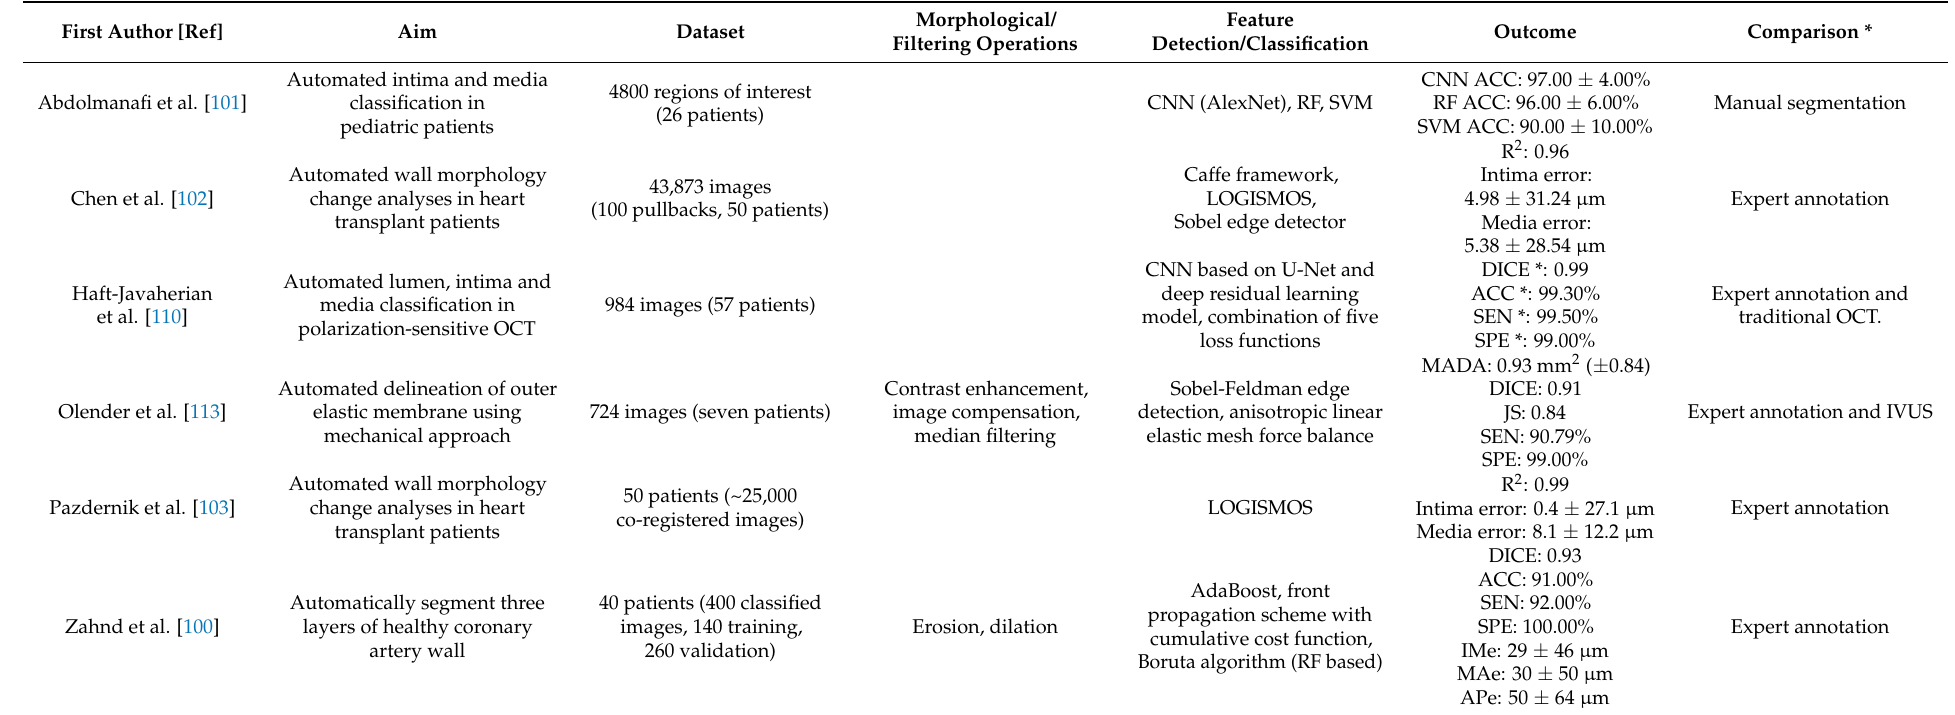
Table A2. Classified articles investigating automated artery layer segmentation. ACC—Accuracy. APe—Adventitia-peri-adventitial tissue border error. CNN— Convolutional neural network. DICE—Dice loss coefficient. IMe—Intima-media border error. IVUS—Intravascular ultrasound. JS—Jaccard similarity